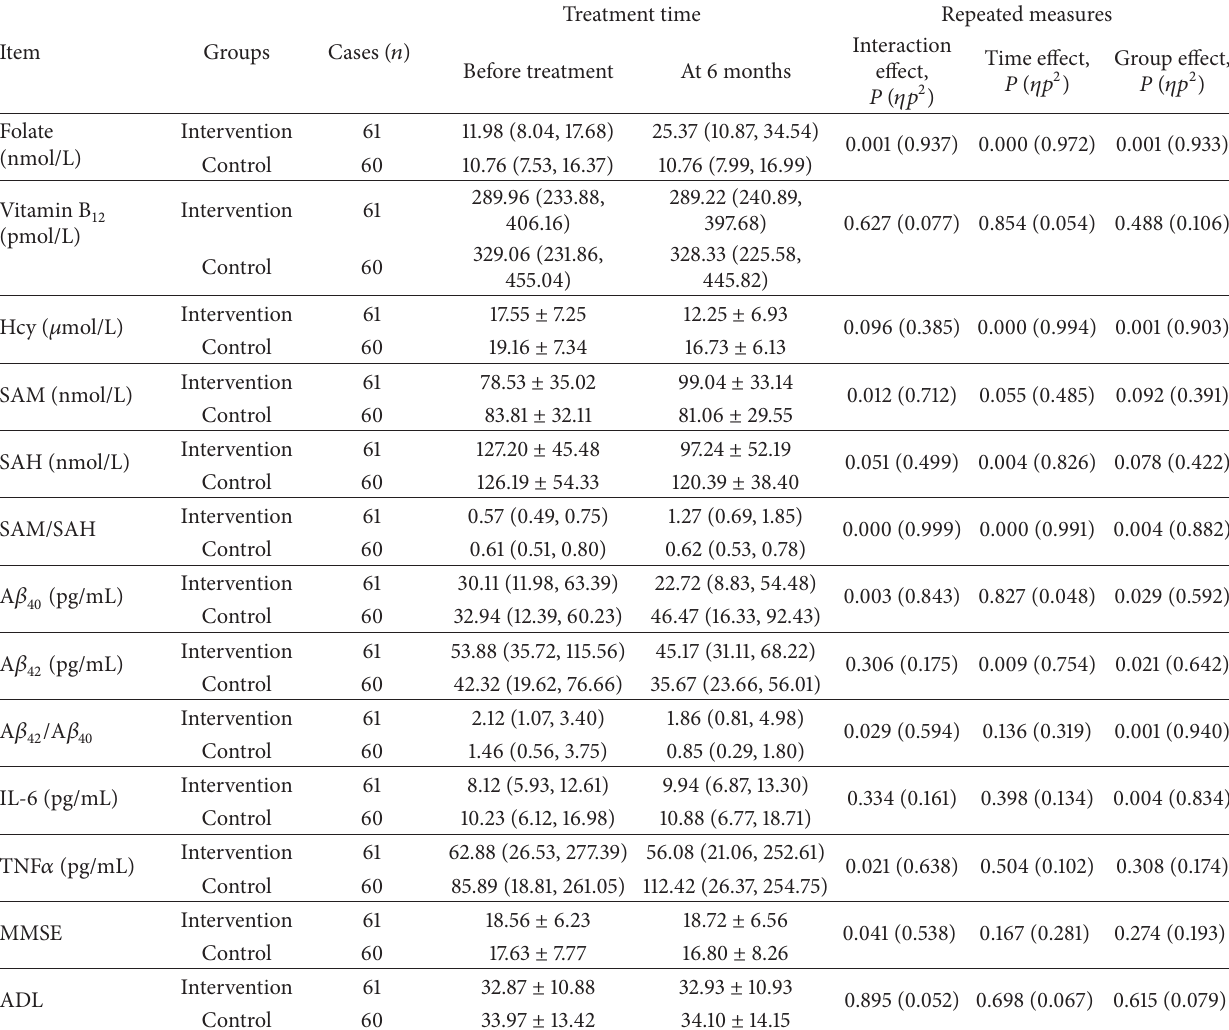
Table 3: The levels of serum biomarkers parameters at baseline and 6-month follow-up in folic acid and control groups.